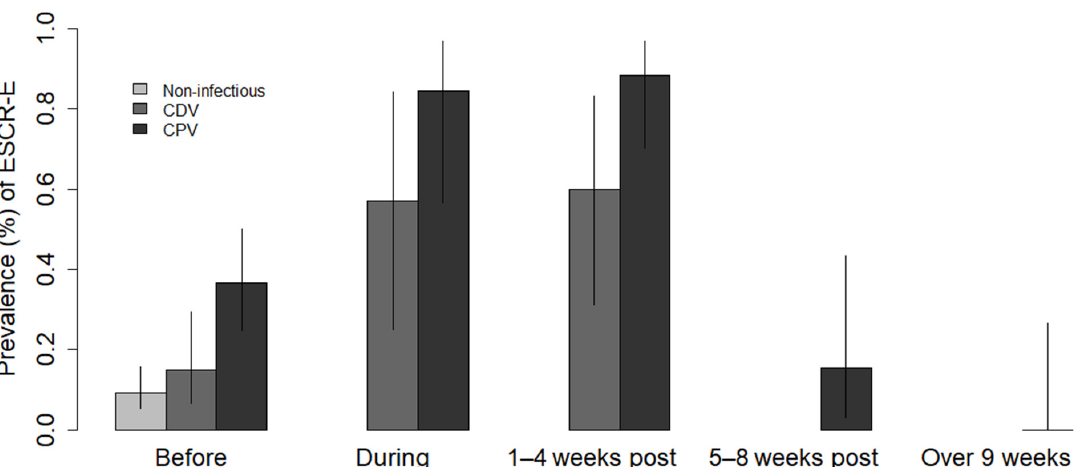
Figure 1. Prevalence of extended-spectrum cephalosporin-resistant Enterobacterales (ESCR-E) faecal carriage in dogs clinically diagnosed with canine parvovirus (CPV) and canine distemper (CDV) infections before, during, and after antibiotic therapy. The prevalence of dogs suspected of CPV and CDV infections was estimated at four periods after the start of antibiotic therapy with third-generation cephalosporin: “During” the 7-day course of ceftriaxone or ceftiofur, “1–4 weeks” post-treatment, “5–8 weeks” post-treatment, and “over 9 weeks” post-treatment. Before the treatment, the prevalence was compared to dogs without infectious diseases prior to their admission to the hospital for other health issues.